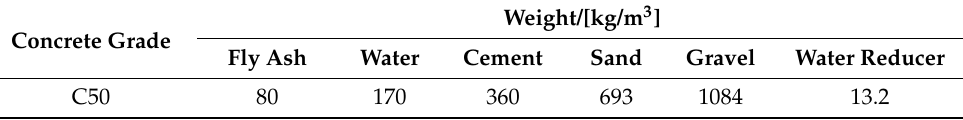
Table 3. Mix proportion of concrete.